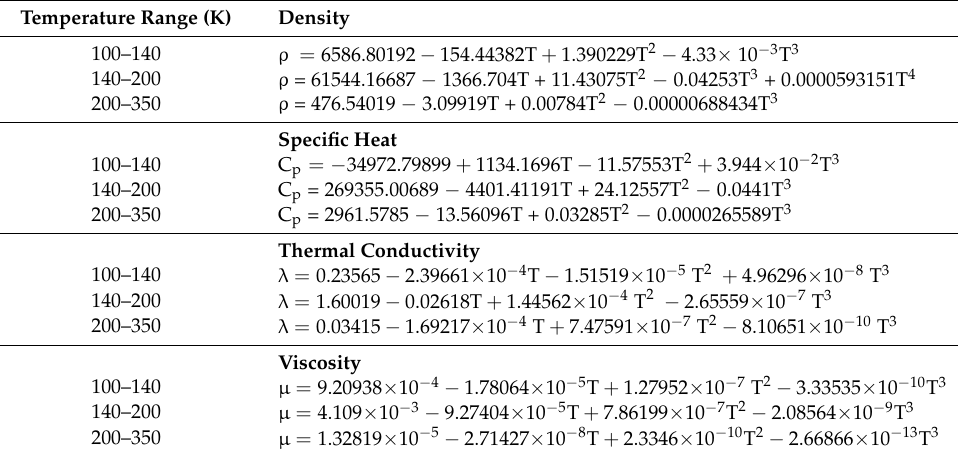
Table 2. Piecewise-polynomial function of physical properties of nitrogen at 6 Mpa.